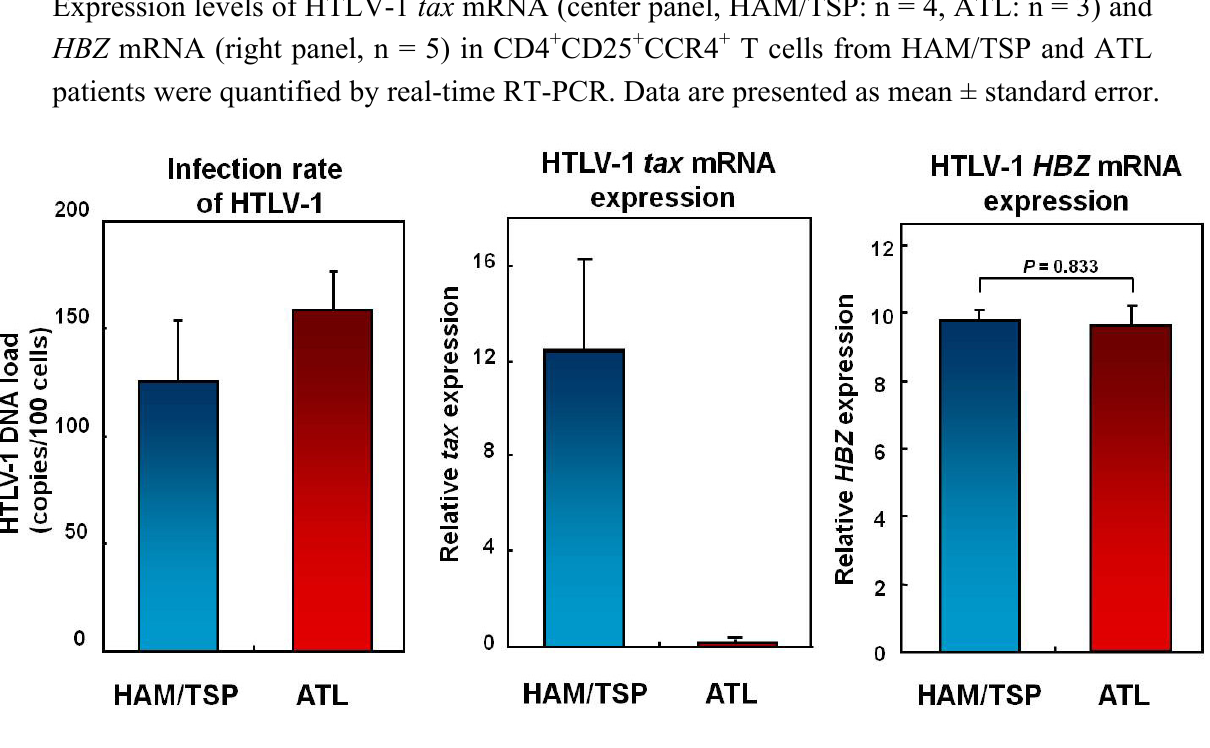
Figure 6. Increased HTLV-1 tax mRNA expression in CD4 + CD25 + CCR4 + T cells in HAM/TSP patients. The HTLV-1 proviral load in CD4 + CD25 + CCR4 + T cells from HAM/TSP and ATL patients was quantified by real-time PCR (left panel, n = 3). Expression levels of HTLV-1 tax mRNA (center panel, HAM/TSP: n = 4, ATL: n = 3) and HBZ mRNA (right panel, n = 5) in CD4 + CD25 + CCR4 + T cells from HAM/TSP and